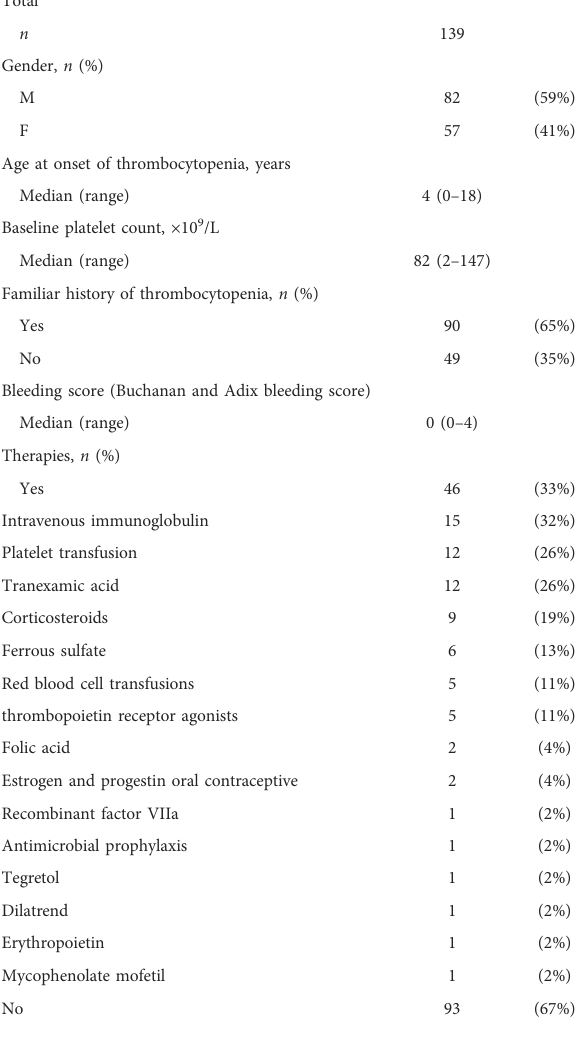
TABLE 1 Demographic and baseline features of the included